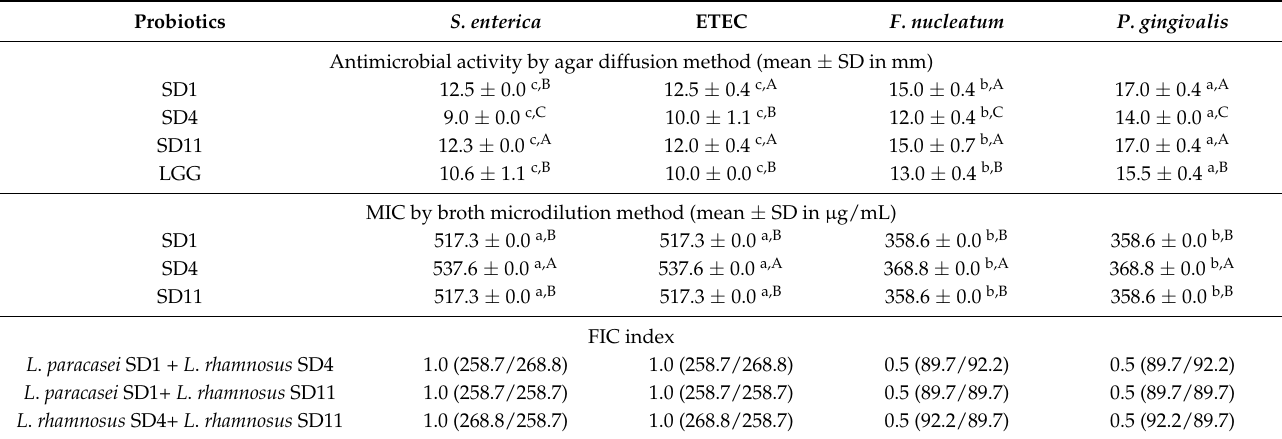
Table 1. Antimicrobial activity of short-chain fatty acids (SCFAs) of probiotics against pathogens. Probiotics S. enterica ETEC F. nucleatum P.